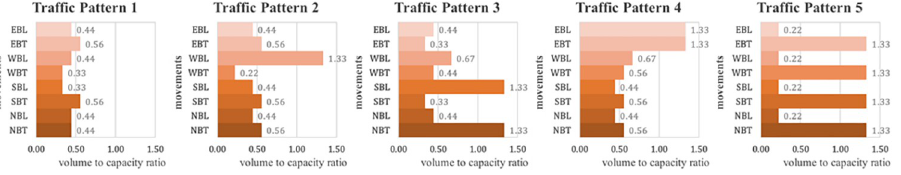
Fig 6. Various traffic patterns for prototype